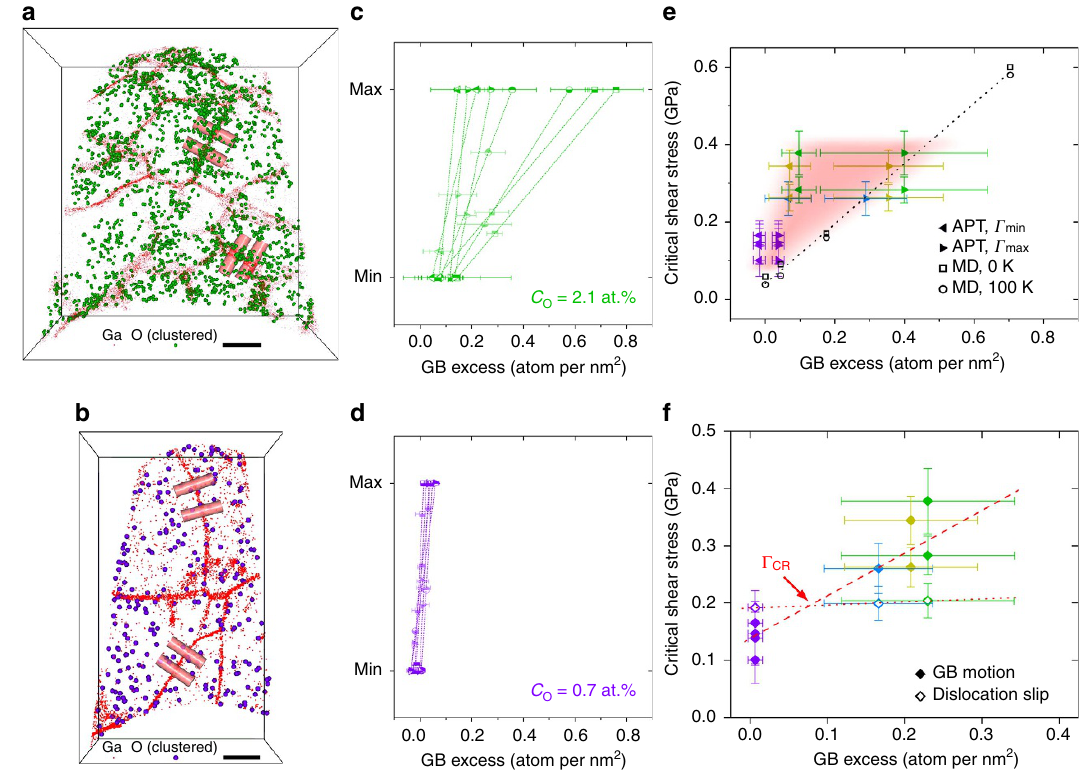
Figure 6 | Quantification of GB excess of O atoms ( C O ) using APTand its role on mechanical stability of NC Al films. ( a , b ) APTreconstructions of films with C O of ( a ) 2.1 and ( b ) 0.7at.% showing the spatial distribution of O-rich clusters relative to GBs, highlighted by segregated Ga implanted during atom- probe sample preparation. Scale bars, 20nm. ( c ) Variation of the areal density of O-rich clusters ( G O ) in the films with C O ¼ 2.1at.% showing large inhomogeneity within a given GB (shown by a single line bounded by the minimum and maximum G O values), as well as between different GBs (shown by different lines). Error bars of G O are determined with the ‘cylinder method’ (Supplementary Fig. 2). ( d ) A much narrower distribution of G O was measured in the film with C O ¼ 0.7at.%. Four representative analysed regions, that is, ‘cylinders’ for such quantification are indicated in a and b . ( e ) Correlation between critical shear stress ( t CR ) of GB migration and G O averaged over all GBs measured by APT. Error bars of t CR are determined as described in Supplementary Figs 11 and 12. Error bars of G O reflect the inhomogeneity between different GBs, and the ranges between local minima (left triangles) and local maxima (right triangles) of G O reflect the inhomogeneity within individual GBs. Atomistic simulations 29 of an Al bicrystal doped with O is shown (open symbols, dotted line) for comparison. ( f ) Full map of correlation between averaged GB excess and t CR for GB migration (solid symbols, linear fitting shown as dashed line) and dislocation propagation (open symbols, linear fitting shown as dotted line). The crossover of these two lines denotes a critical GB excess ( G CR ) for a transition of deformation mechanism that maintain NC microstructural stability under mechanical